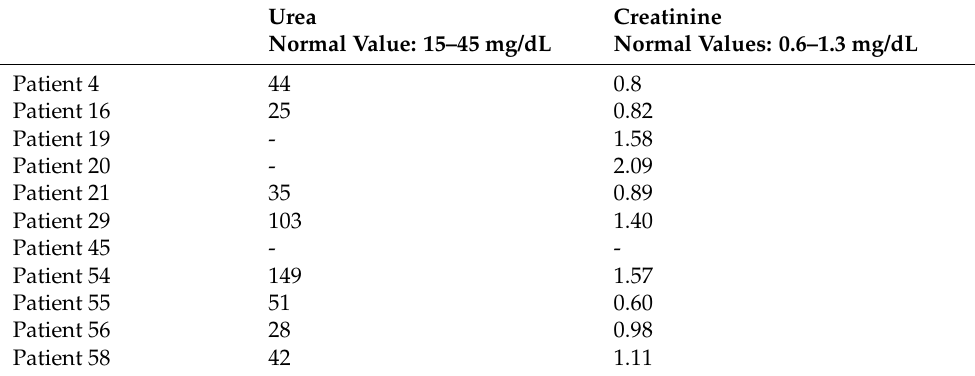
Table 7. Urea and creatinine dosage levels for ATTR patients.